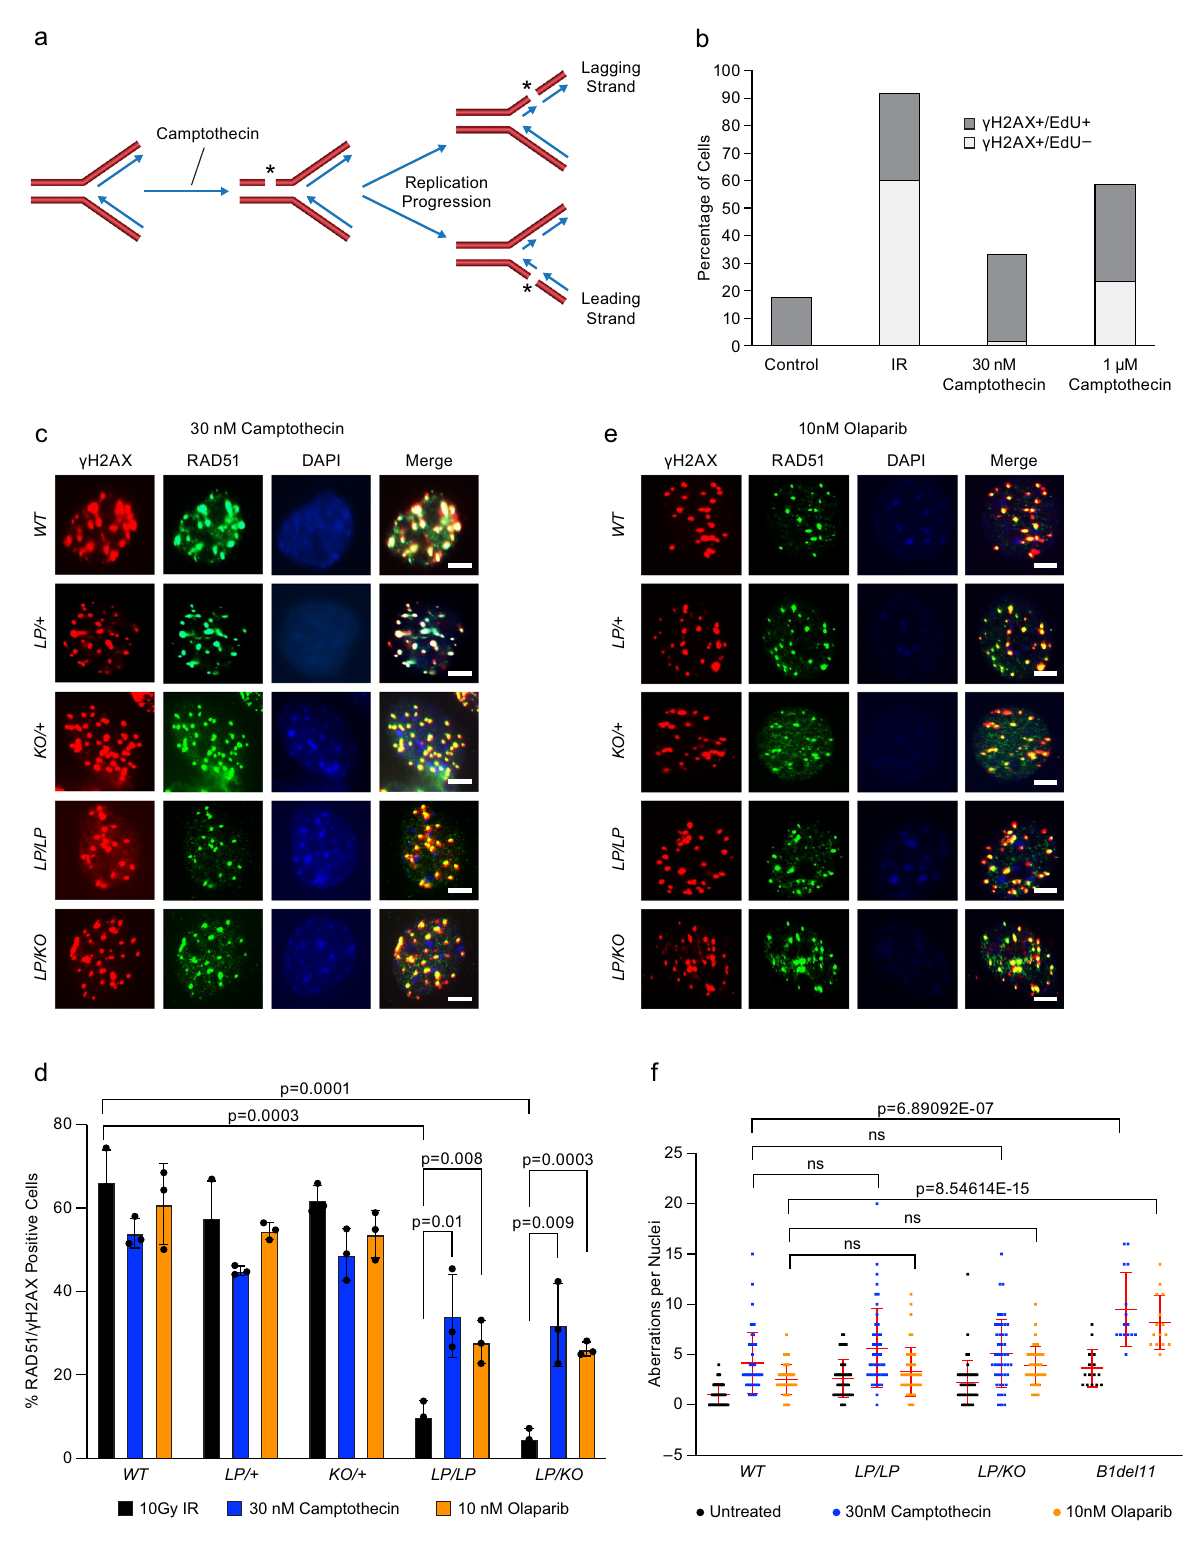
a signi fi cant increase in RAD51-foci-positive Brca2 LP/LP and Brca2 LP/KO MEFs compared to irradiated MEFs (Fig. 5d, e). Taken together, these results suggest that there is a difference in the requirement of BRCA2-DSS1 interaction between IR and camp- tothecin or olaparib-induced DSB repair via HR. It is possible that when the homologous DNA is present near the DSB, BRCA2-DSS1 interaction is dispensable for RAD51 loading at